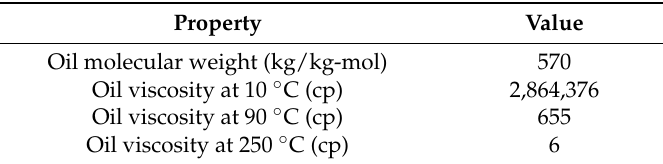
Table 2. Properties of the oleic